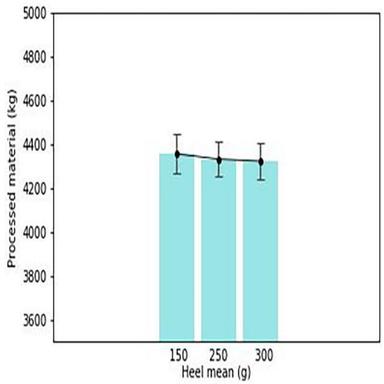
The average amounts of processed material given the heel amounts of 0.15 kg, 0.25 kg, and 0.3 kg are 4355 kg, 4332 kg, and 4322 kg.